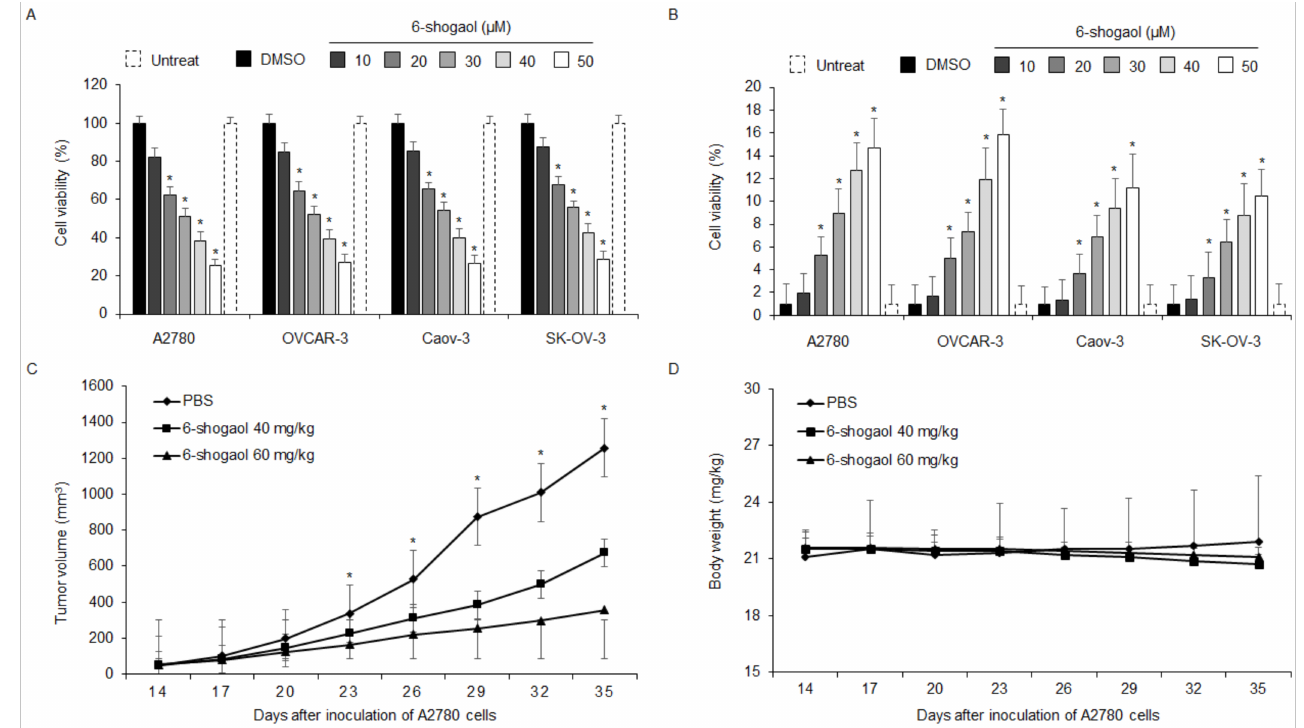
Figure 1. Anti-cancer effects of 6-shogaol in ovarian cancer cell lines in dose-dependent manner. ( A , B ) Cell viability and LDH cytotoxicity of a dose-dependent 6-shogaol, in ovarian cancer cell lines, including A2780, OVCAR-3, Caov-3, and SK-OV-3, measured using the WST-1 assay and LDH assay on 96-well plates; *, p < 0.05. ( C , D ) A2780 cells (1 × 10 7 ) were implanted (sc) into the thigh on the right hind leg of nude mice (n=10/group). 6-shogaol (40 or 60 mg/kg) or PBS was administered (ip) once a day for two days. The longest (L) and shortest (W) axes of the tumors were measured, and the tumor volume (mm 3 ) was calculated as LW2/2. Body weights of the A2780 tumor xenograft mice were determined twice a week during the experiment; *, p <